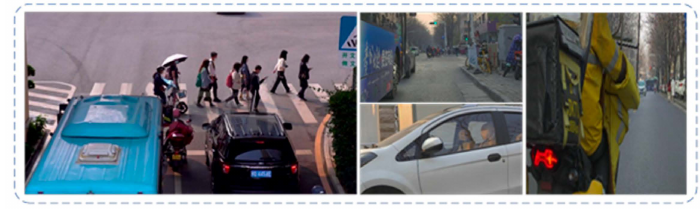
Figure 1. Typical scene of intelligent vehicles near field